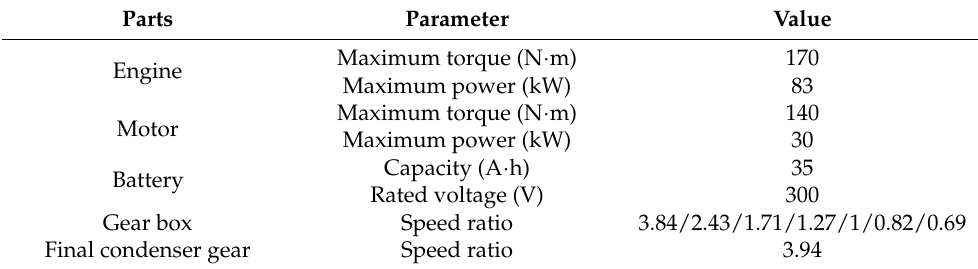
Table 1. Key component parameters.